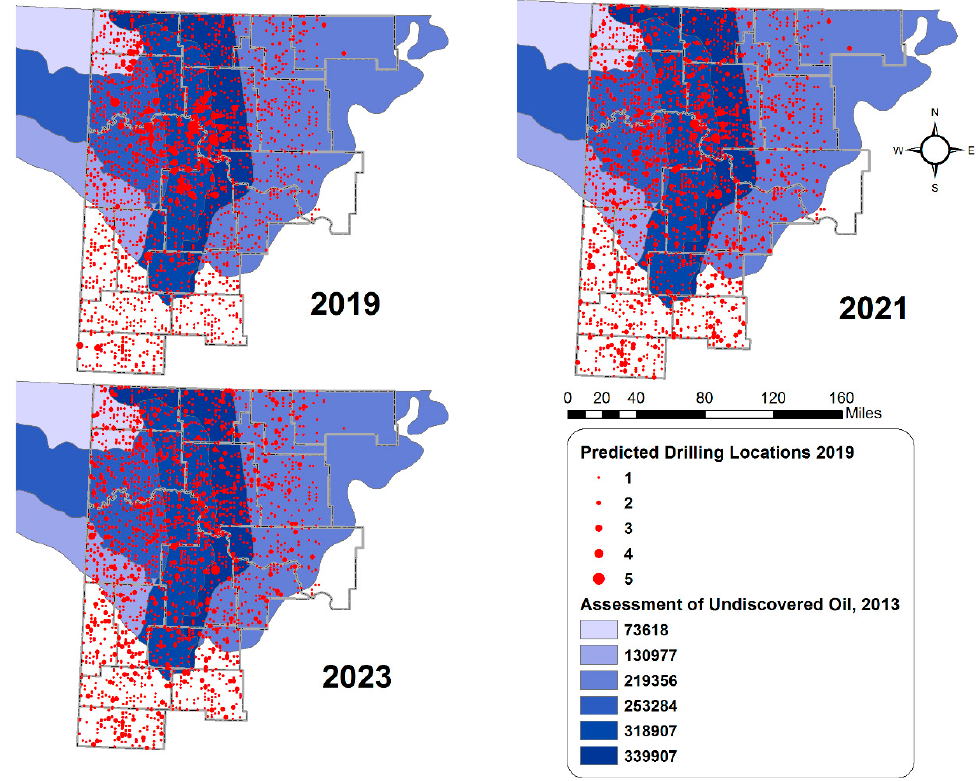
Figure 5. Spatial distribution of the oil drilling locations over the years.